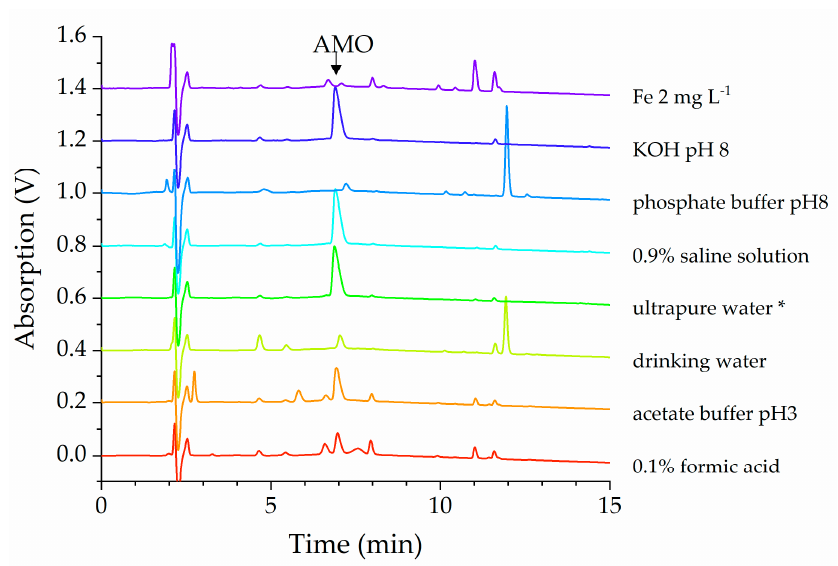
Figure 3. Stacked UV-chromatogram sections of AMO solutions detected at 230 nm. Samples were stored at room temperature for 10 days in the dark (* except ultrapure water, which was stored under light influence), AMO eluted at 6.7 min.